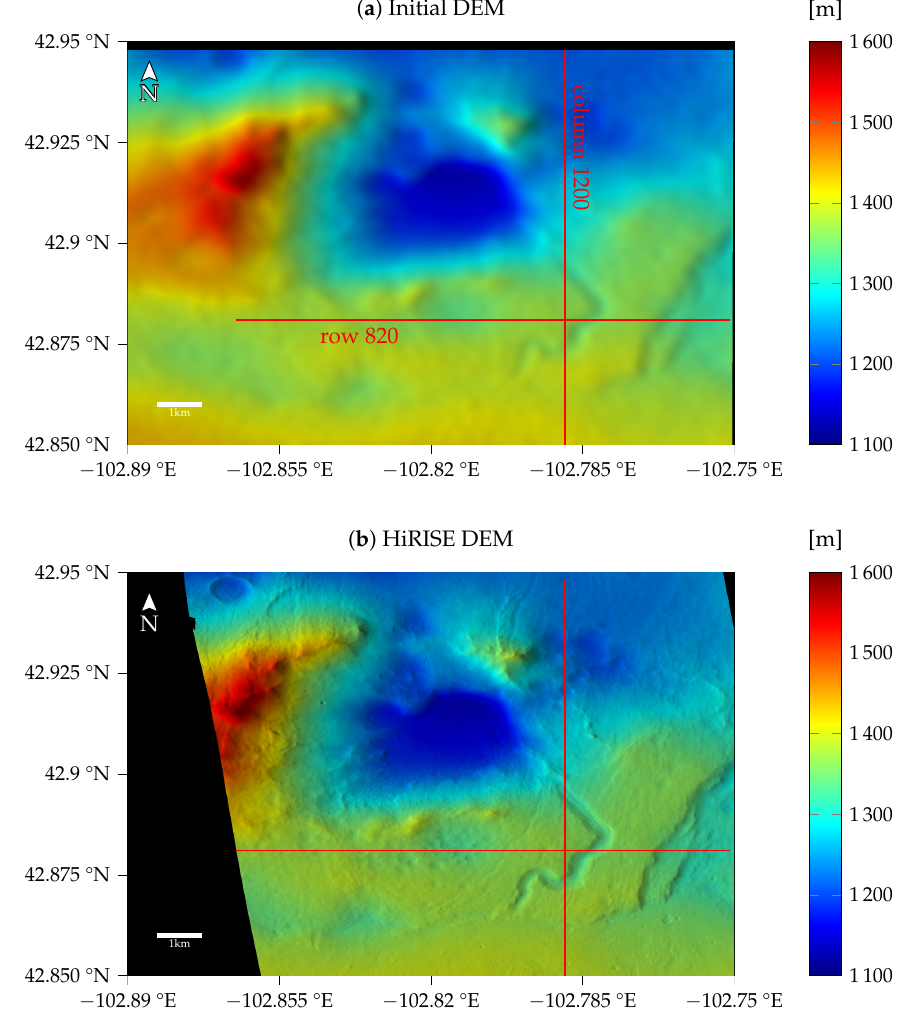
Figure 5. Initial DEM based on CTX stereo image pair and ground truth DEM based on HiRISE stereo image pair. Red lines indicate the profiles that will be investigated in this